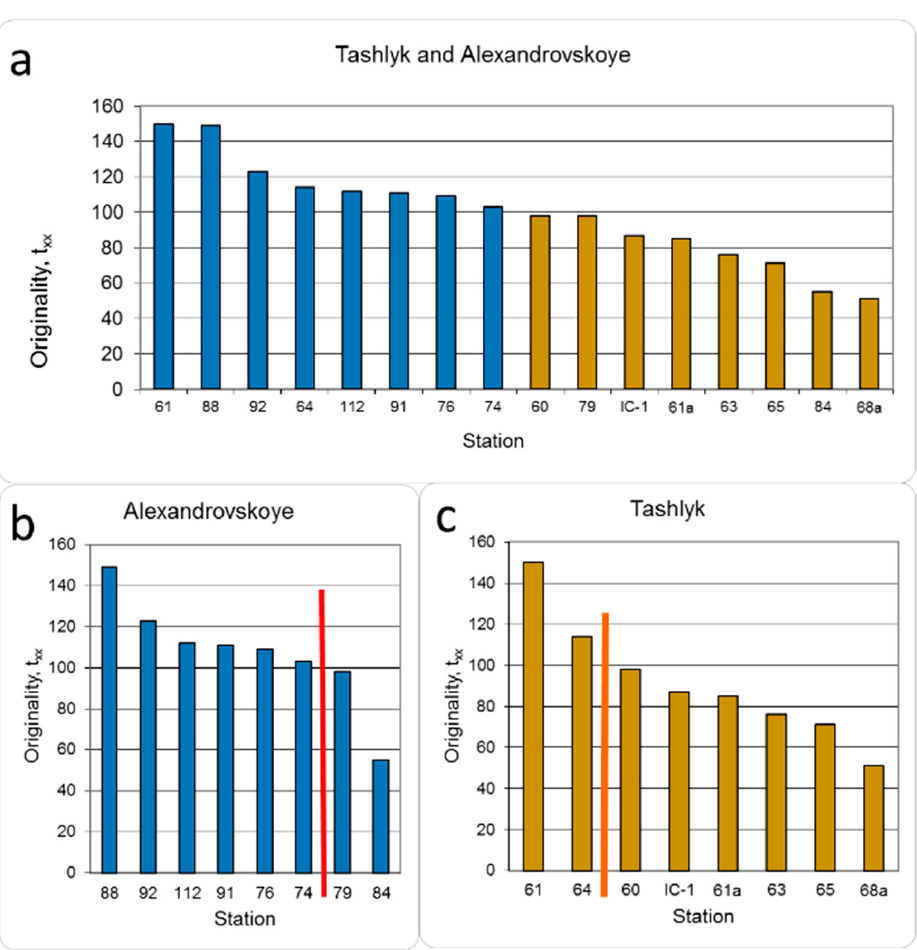
Figure 3. Originality of phytoplankton composition at stations: from all lists of LIT ( a ); Tashlyk reservoir ( b ); Alexandrovskoye reservoir ( c ). The red line separates stations where txx originality values are greater than and less than 100.